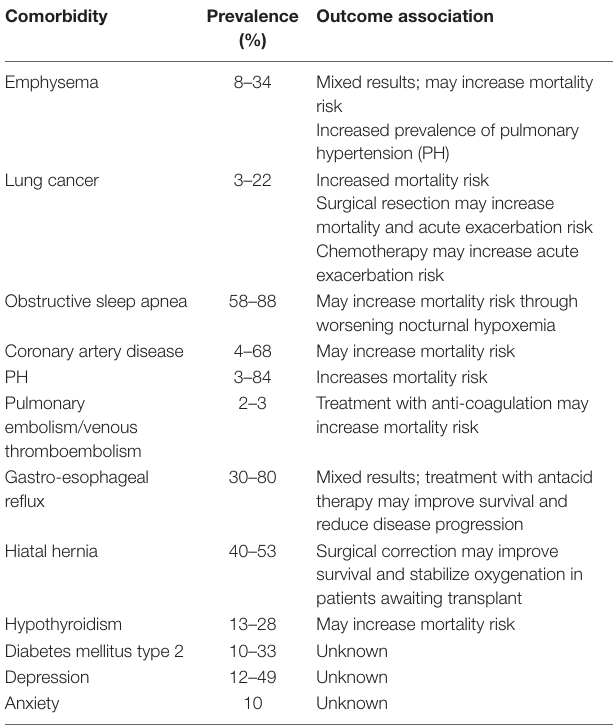
TABLe 1 | Common comorbidities in patients with idiopathic pulmonary fibrosis.